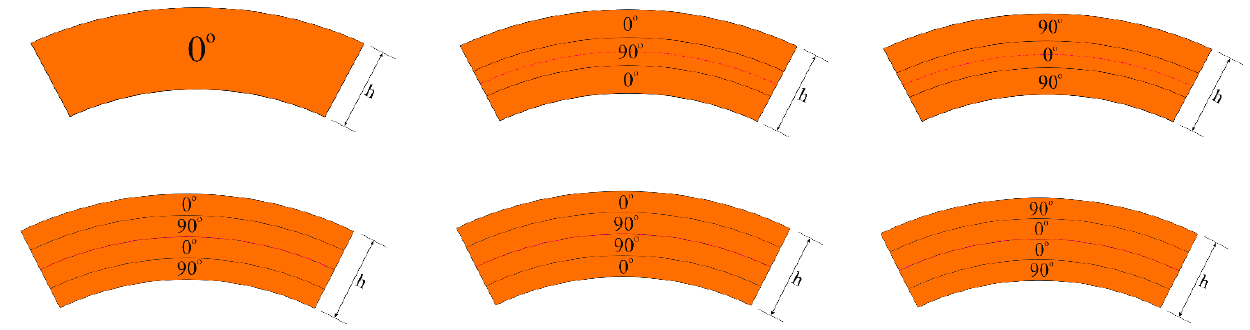
Figure 3. The cross-section types of laminated and single-layer truncated conical shell. Figure 3. The cross ‐ section types of laminated and single ‐ layer truncated conical shell.